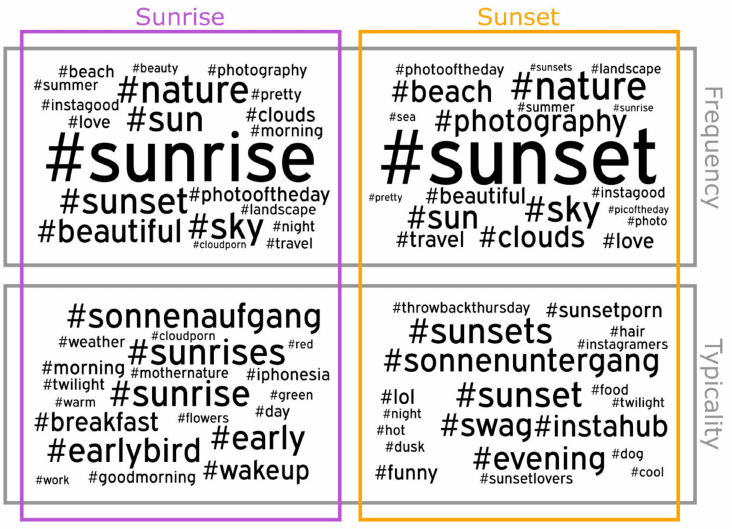
Figure 1. Word clouds of the frequency- and typicality-based top 20 hashtags of the global sunset- and sunrise-related sub-datasets.